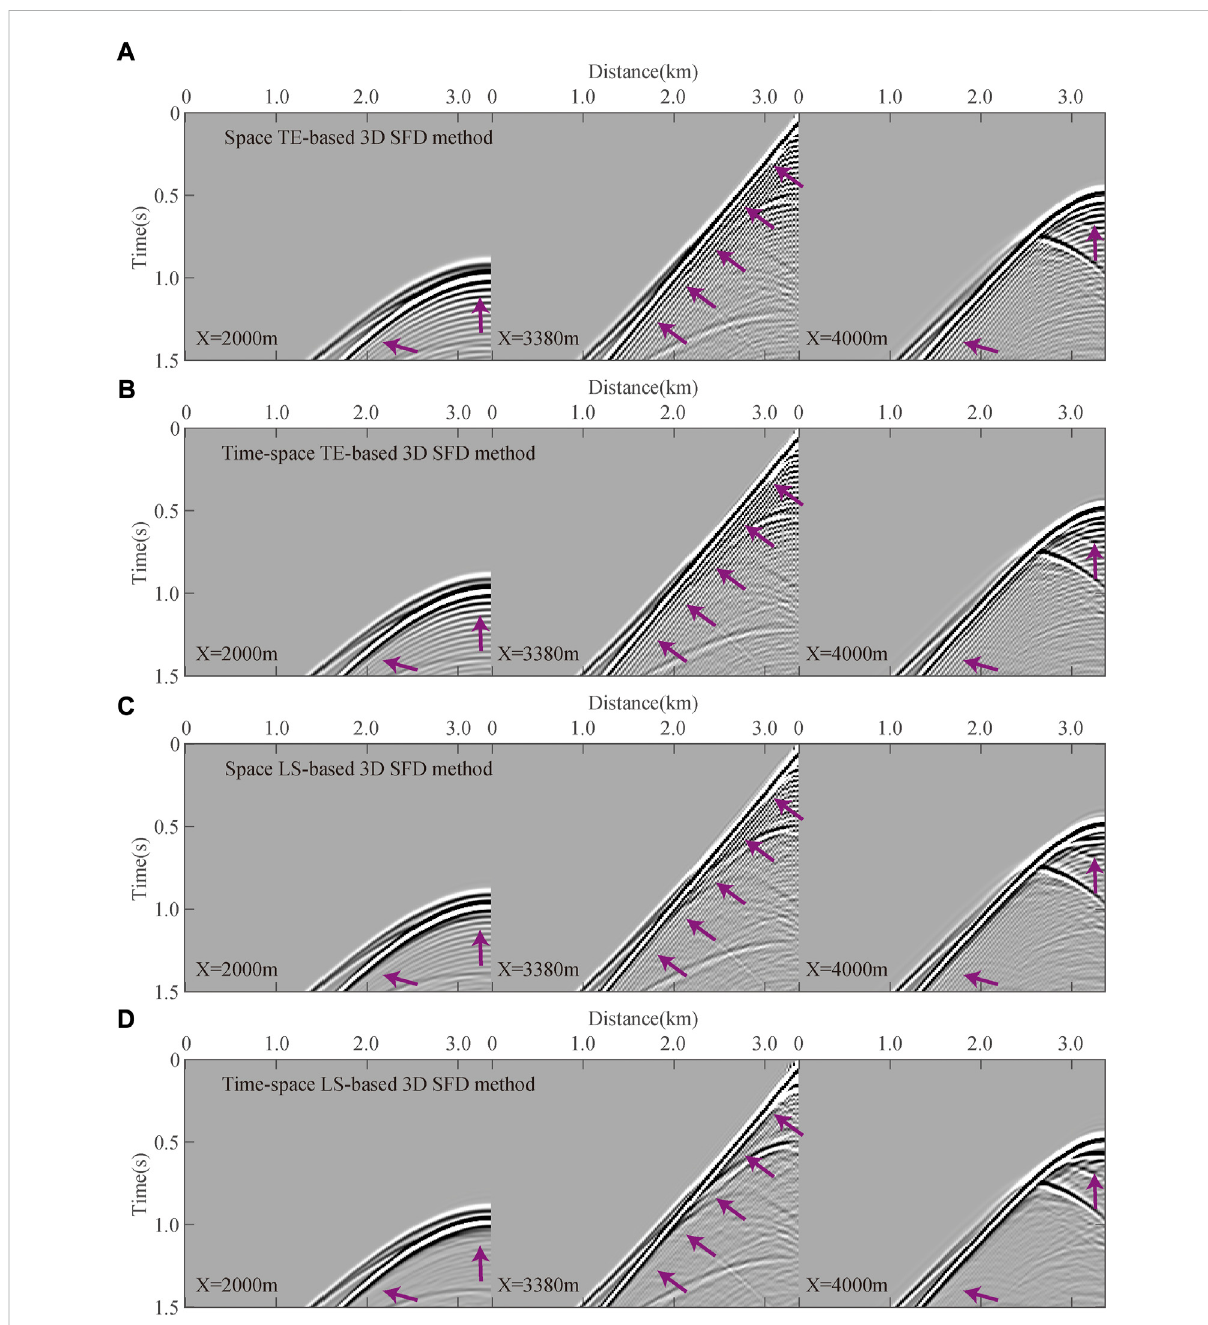
FIGURE 13 Local 2D slices of the 3D seismic records generated by different 3D SFD methods ( M (cid:2) 5) along y direction for the 3D SEG/EAGE salt model. These subgraphs (A – D) indicate different positions and different 3D SFD methods listed in